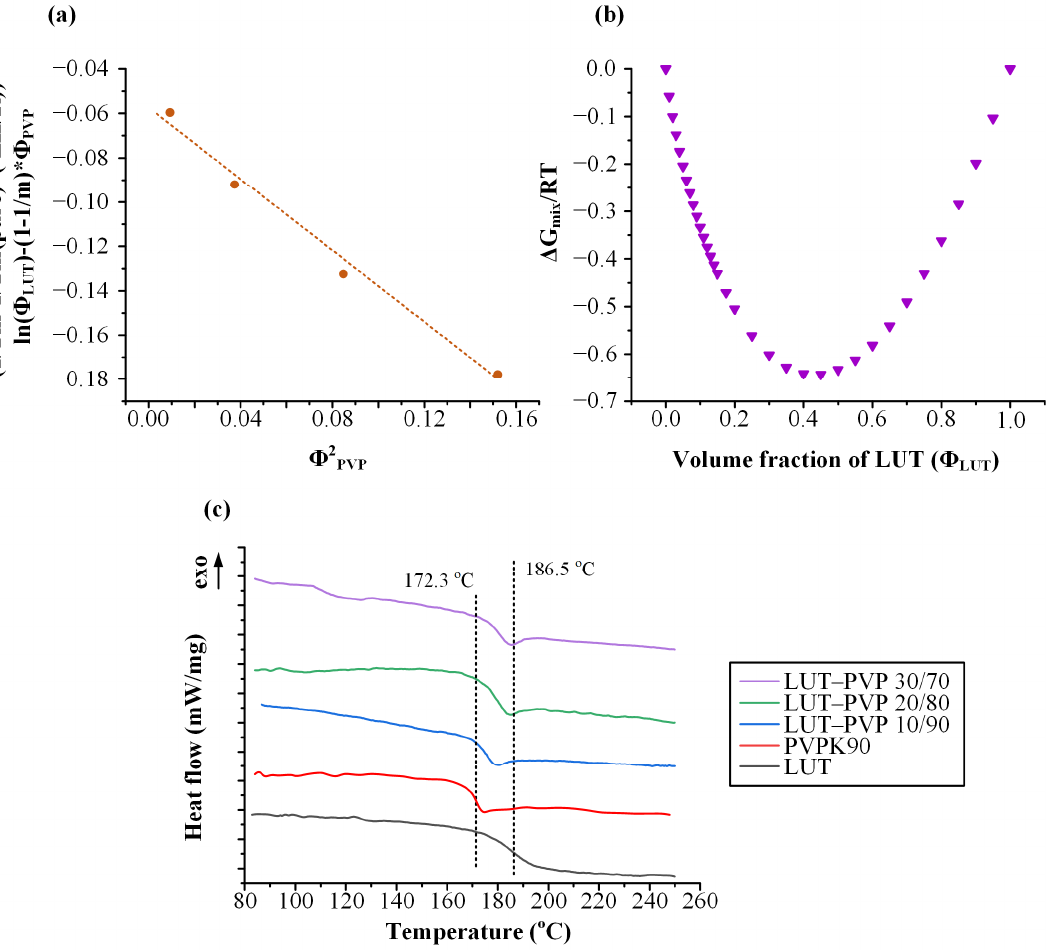
Figure 4. ( a ) FH interaction parameter estimation plot, ( b ) ∆ G mix /RT vs. Φ LUT plot, and ( c ) DSC depicting T g values for the raw materials, and the LUT-PVP mixtures at 10, 20, and 30% w / w of API. Note: The symbol * at the picture ( a ) is used as a multiplication symbol.